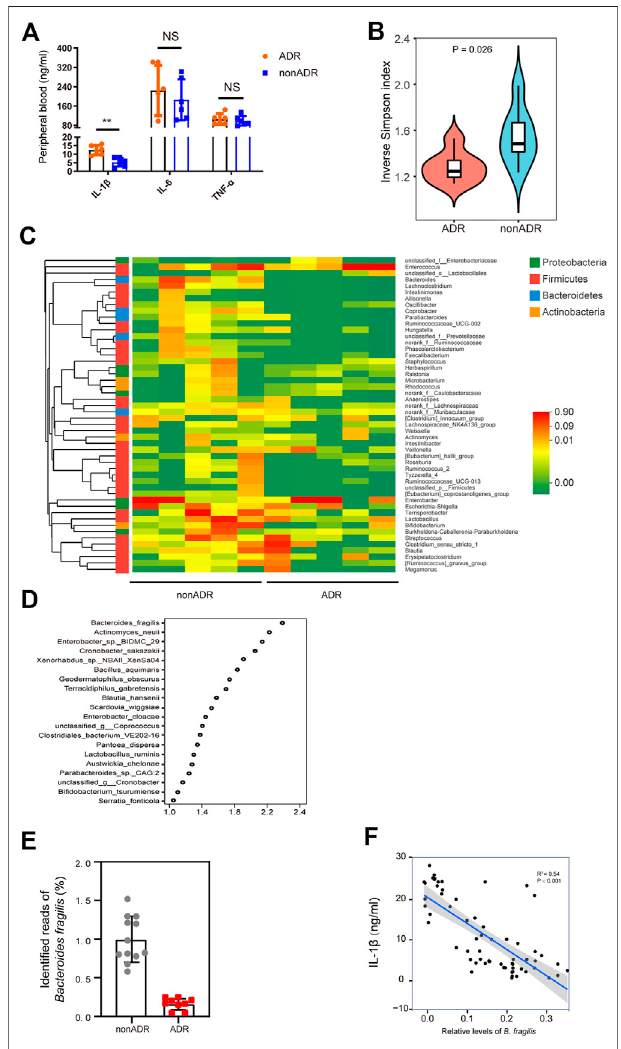
FIGURE 2 | Pro fi ling of the gut microbiota and pro-in fl ammatory cytokines in individuals with AML. (A) Pro-in fl ammatory cytokine concentrations were determined in peripheral blood ( n (cid:1) 6, respectively). (B) Alpha diversity, measured by the inverse Simpson index ( n (cid:1) 6, respectively). (C) Community heatmap analysis at genus level ( n (cid:1) 5, respectively). (D) VIP scores of PLS-DA. VIP scores ranked discriminating power of various taxa between nonADR and ADR groups. Taxon with VIP scoreof > 1wasconsideredimportantindiscrimination. (E) Identi fi edreadsof B. fragilis in ADR and nonADR patients. (F) Scatterplots of IL-1 β levels in periheral blood vs. relative levels of B. fragilis . R 2 and p -values of the regression model are shown on the fi gures.